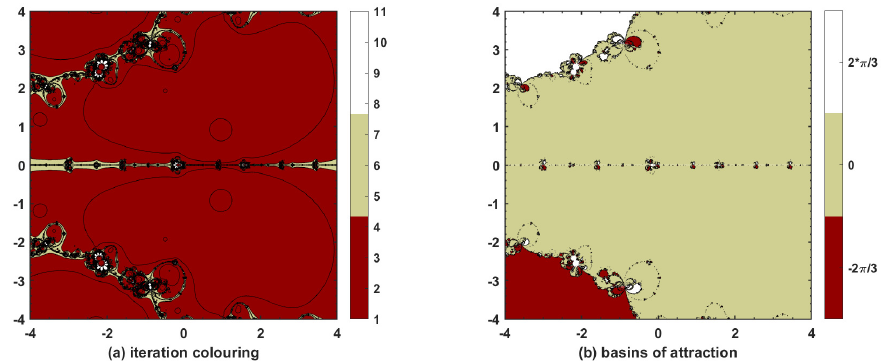
Figure 8. The basins of attractions by the proposed method PM 10 for P 6 ( z )